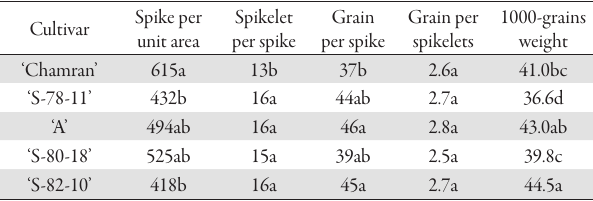
Tab. 2. Grain yield (kg ha -1 ) and yield components of